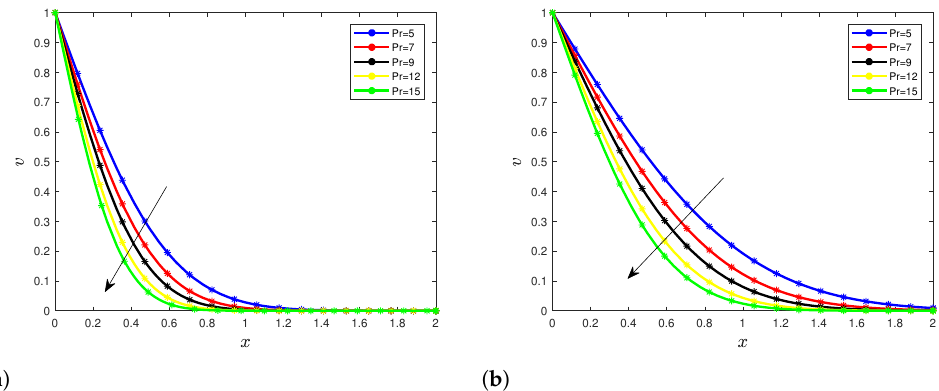
Figure 5. Dynamics of the fractional heat equation with various orders with, respectively, τ = 0.5 ( a ) and τ = 1.5 ( b ) with α = 0.95.